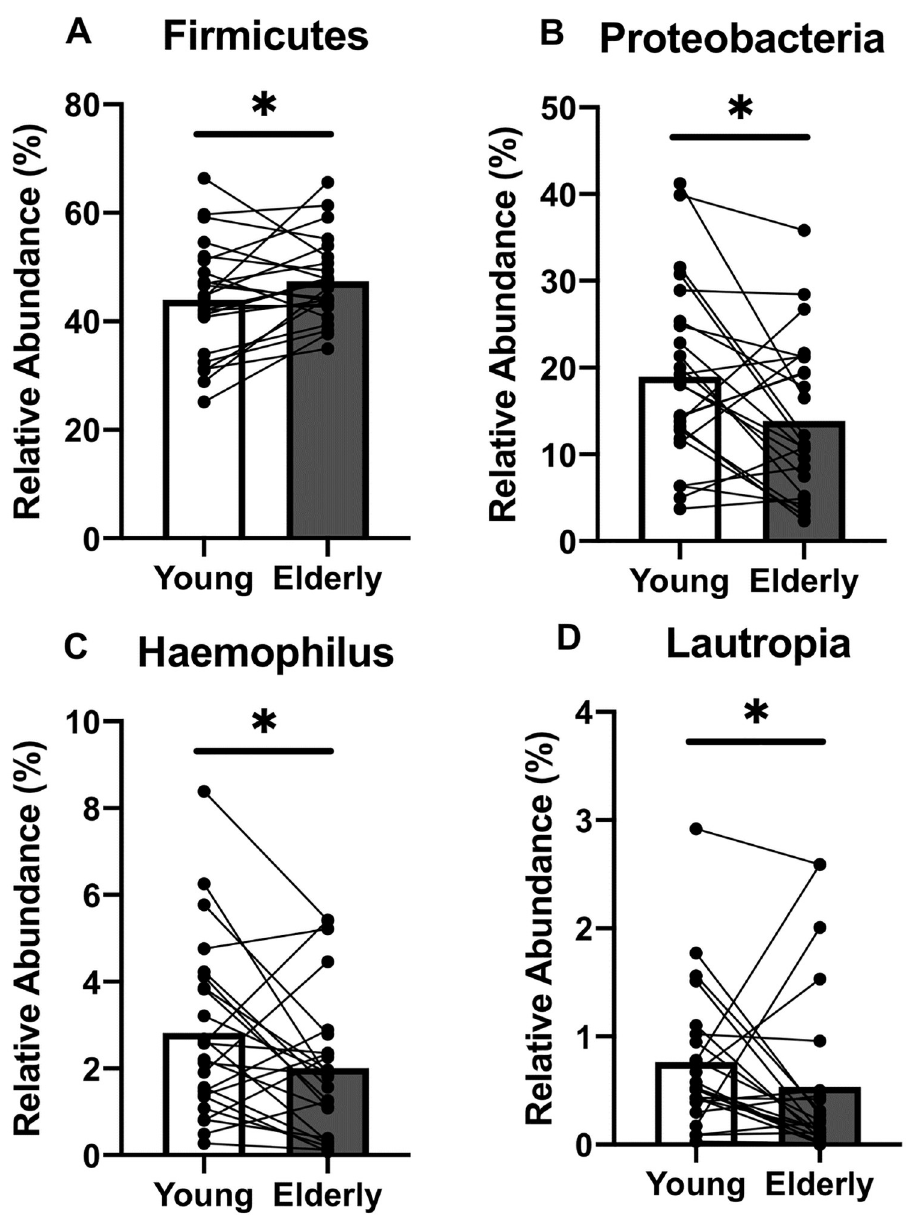
Fig 2. Differentially abundant taxa are observed in genetically paired young and elderly subjects. At the phylum level, differences in Firmicutes (A) and Proteobacteria (B) are observed between young (white bars) and elderly (grey bars) paired groups, with elderly adults exhibiting higher relative abundance of Firmicutes, and lower relative abundance of Proteobacteria than young adults. At the genus level, Haemophilus (C) and Lautropia (D) are differentially abundant, with lower relative abundance in elderly than in younger adults. Black connecting lines indicate young-elderly pairs. � = p <